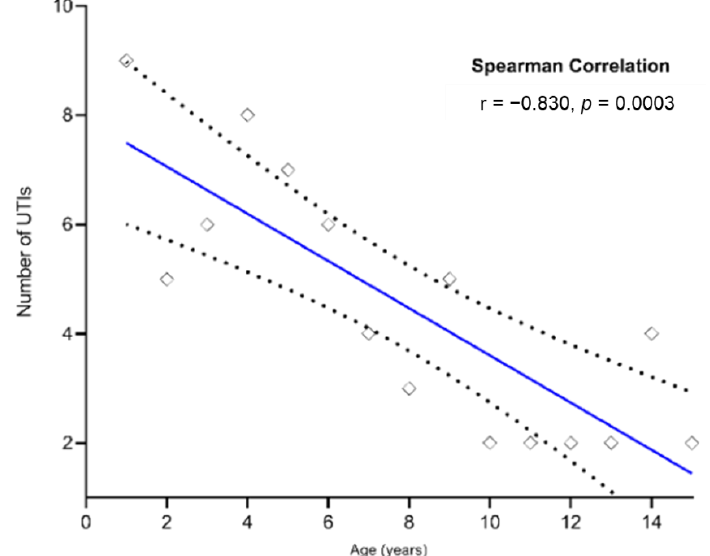
Figure 3. Correlation analysis between the children of all ages and UTIs by UPEC. The correlation analysis indicates that the number of UTIs reduces with children’s age, and hence this figure uses a number so that the relationship is evident across ages from 0 to 15 years. Each marker denotes a sum observation of UTIs for a particular age of the children. Spearman’s correlation was performed by GraphPad Prism, and significance was considered to be established when p > 0.05.